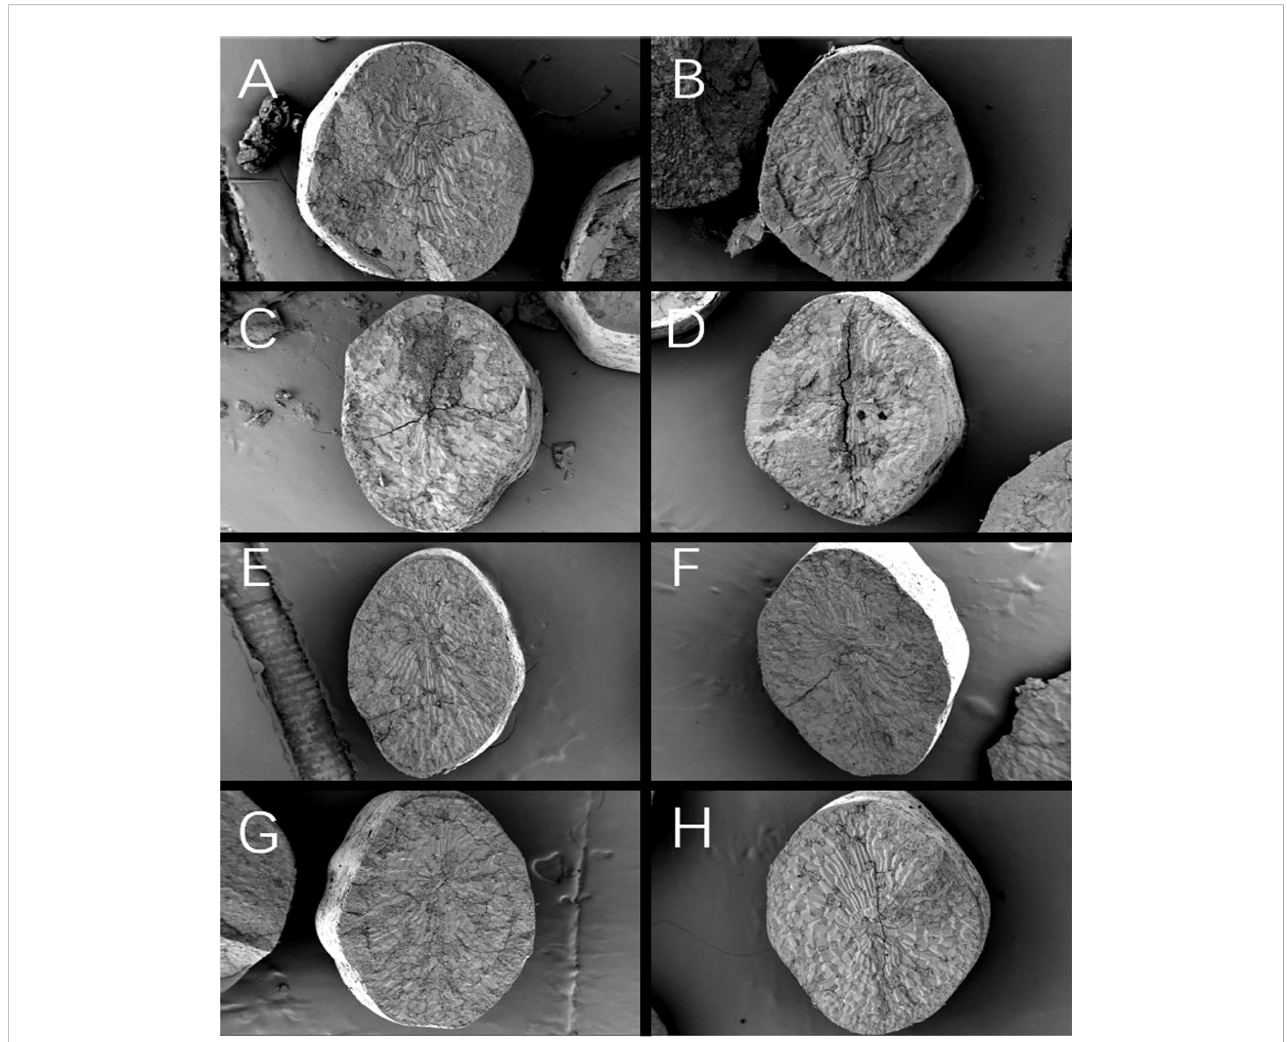
FIGURE 2 Cross-section of rice grains: normal grains of (A) Y28, (B) N5718, (C) W113and (D) Y5118; non-chalky grains of (E) Y28, (F) N5718, (G) W113 and (H)